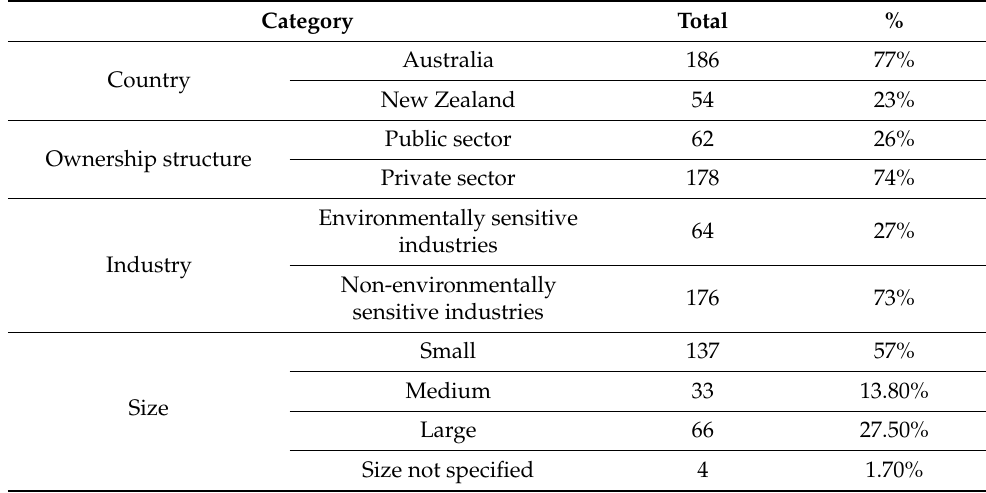
Table 1. Sample descriptive